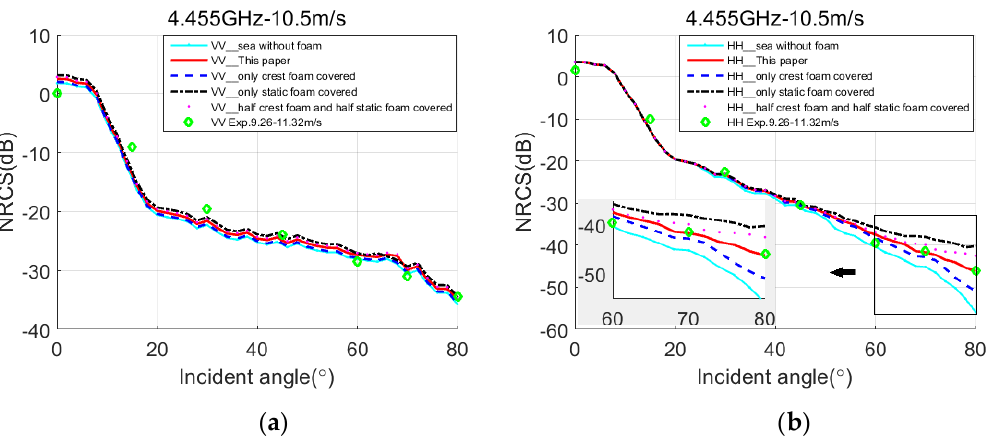
Figure 9. Comparison results of NRCS by the proposed model, the sea surface covered with crest foam only, the sea surface covered with static foam only, the sea surface covered half crest foam and half static foam, and the measured data from JOSS-I model. f = 4.455 GHz, U 10 = 10.5 m / s. ( a ) VV polarization. ( b ) HH polarization.